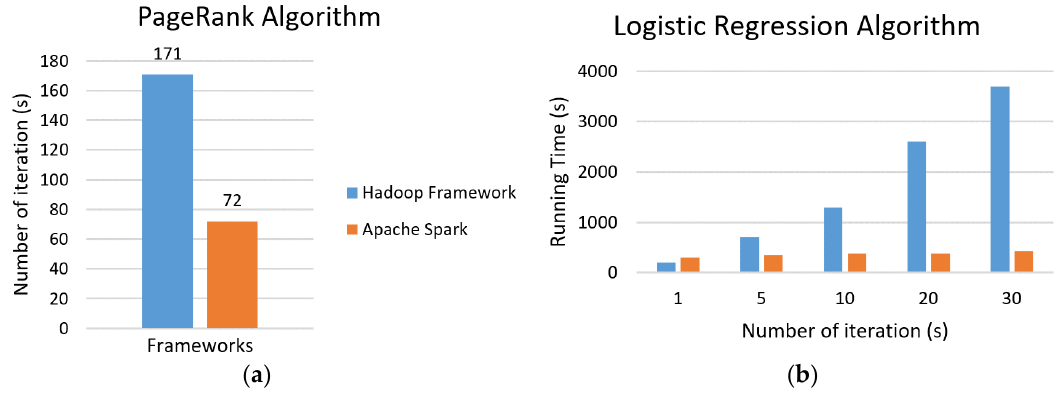
Figure 11. Comparison of performance for ( a ) PageRank and ( b ) logistic regression algorithm.